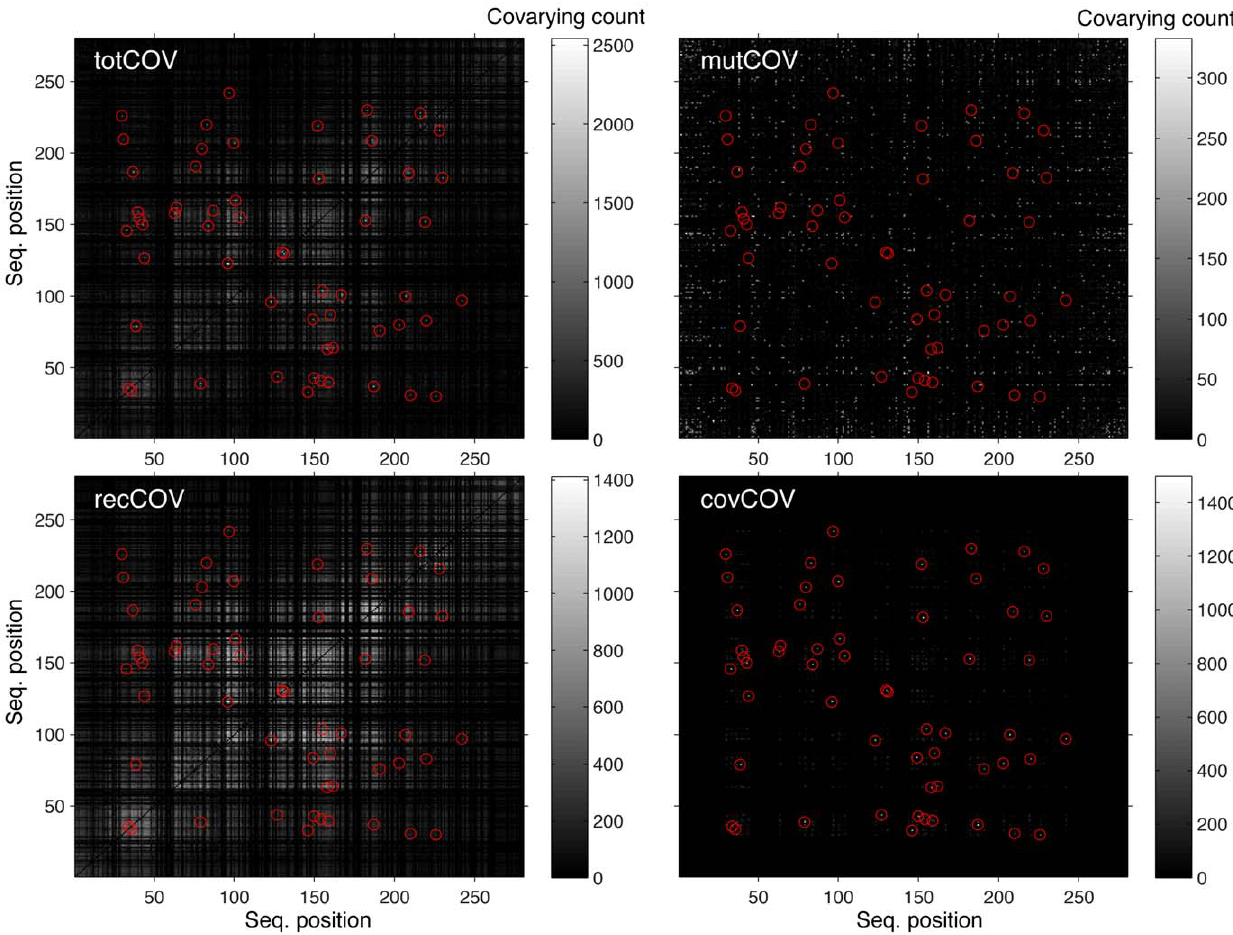
Figure 3. Coevolution matrices derived from a simulated MSA. totCOV : total count of all coevolution events. Although this matrix is built independently during the simulated evolution of the MSA from a single ancestor, it can also be obtained as the sum of the mutCOV, covCOV, and recCOV matrices (see below). Residue pairs under coevolution constraint (true covarions) are indicated by red circles. mutCOV : count of coevolution events due to random point mutations at positions that are not set to coevolve. recCOV : count of coevolution events due to recombination. This count includes residues pairs that are true covarions. covCOV : count of true covarions. There are counts also at pairs of positions that were not set to be covarying because when two or more covarion pairs mutate and segregate also the cross-counts between pairs are